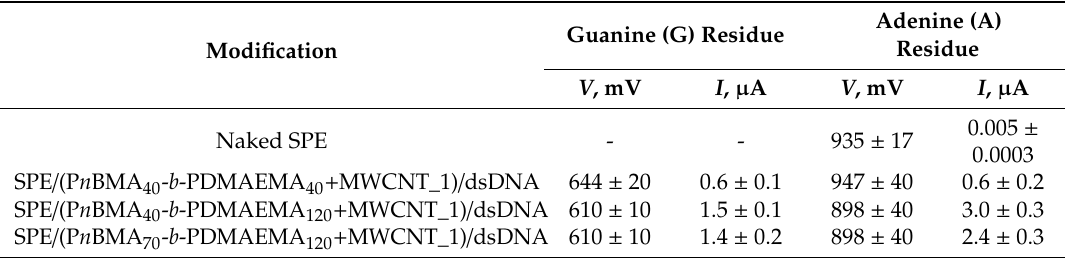
Figure 2. ( a ) Typical DPVs for the SPE/(P n BMA 40 - b -PDMAEMA 120 + MWCNT_1) in the absence (dashed line) or in the presence (solid line) of dsDNA. ( b ) The mechanisms of electrochemical oxidation of guanine and adenine residues. ( c , d ) Comparative current responses for guanine ( c ) or adenine ( d ) peaks for (1) SPE/(P n BMA 40 - b -PDMAEMA 40 + MWCNT_1)/dsDNA, (2) SPE/(P n BMA 40 - b -PDMAEMA 120 + MWCNT_1)/dsDNA, and (3) SPE/(P n BMA 70 - b -PDMAEMA 120 + MWCNT_1)/dsDNA constructs. Conditions: dsDNA was deposited onto the SPE/(P n BMA x - b - PDMAEMA y + MWCNT_1) constructs from a 1500 µg/ml solution. The incubation time after dsDNA deposition was 15 min.